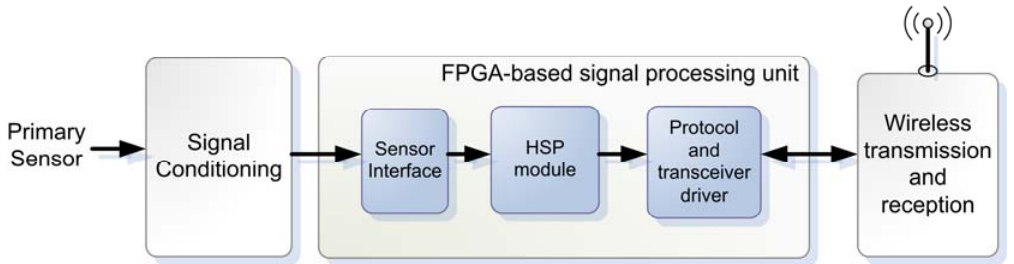
Figure 2. Wireless smart sensor system